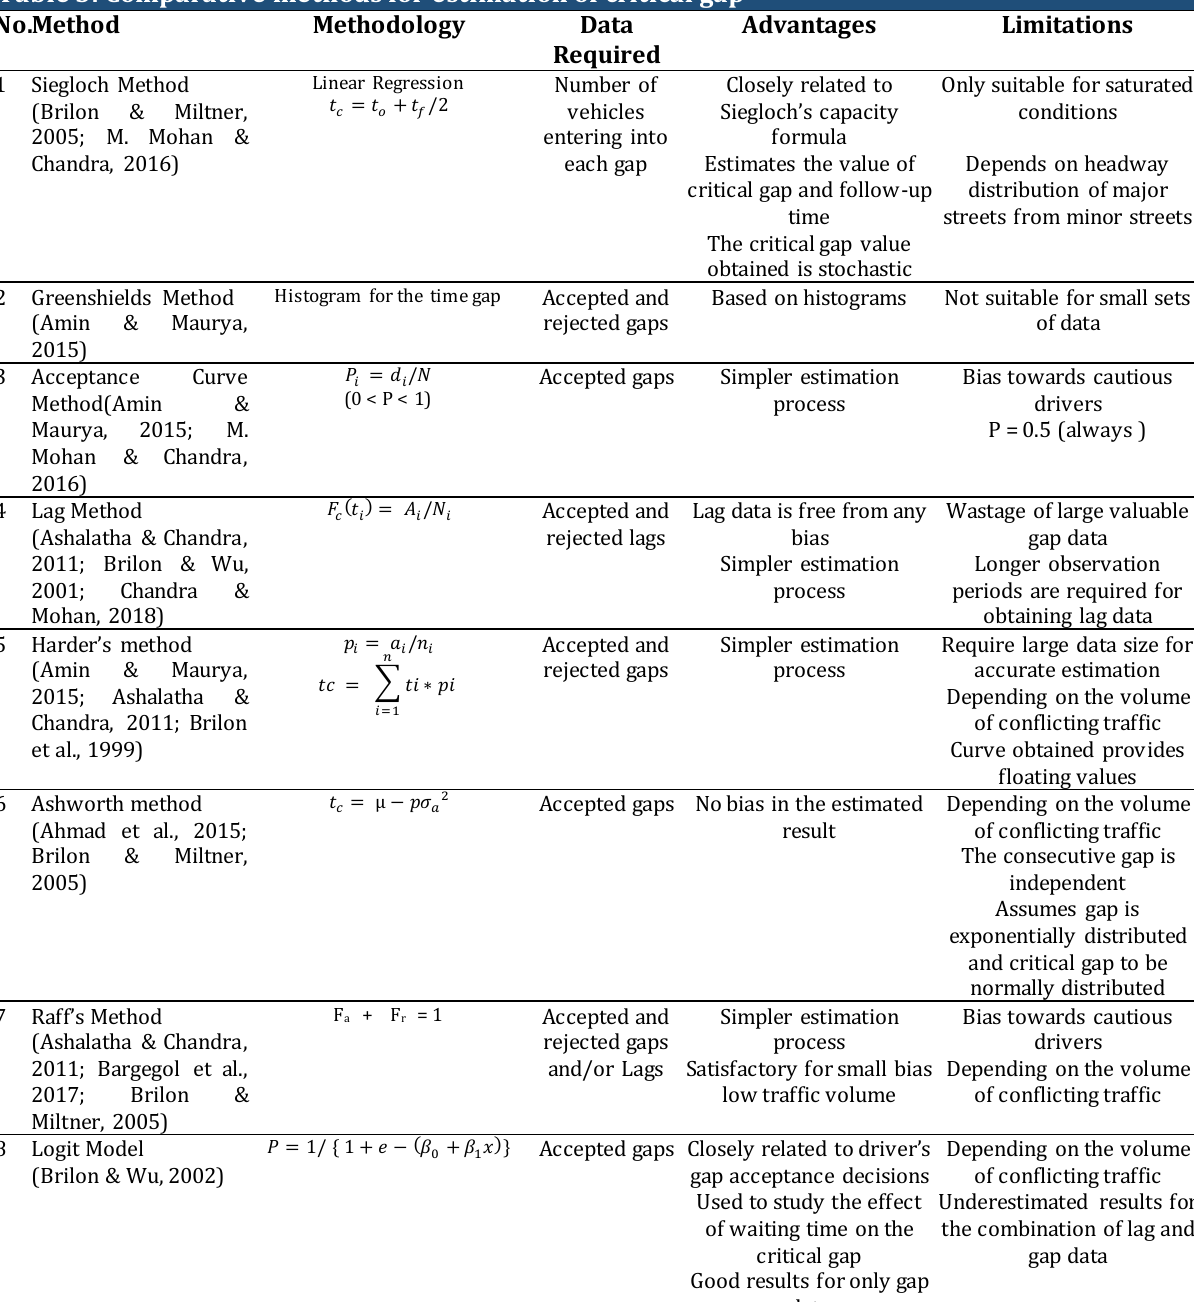
Table 3: Comparative methods for estimation of critical gap No.